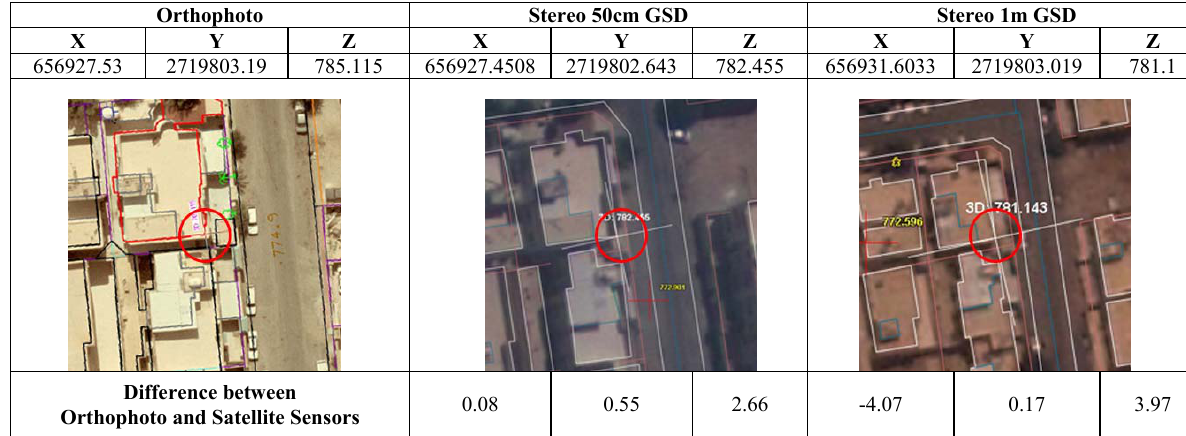
Table 1i. Showing capturing of building corner based on different resolutions of